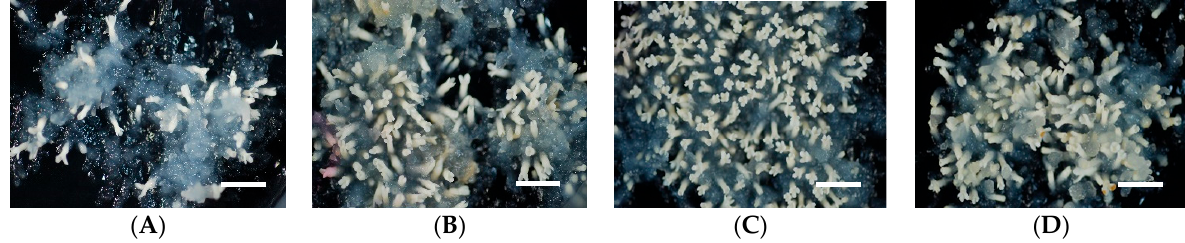
Figure 3. Somatic embryo maturation of sugi S-18 ECL on medium containing different amino acid (AA) concentrations: ( A ) 0 × , ( B ) 1 × , ( C ) 2 × , and ( D ) 3 × . Bars: 5 mm. 2.6. Effect of Proliferation Culture Medium (PCM) on Somatic Embryo Maturation Efficiency